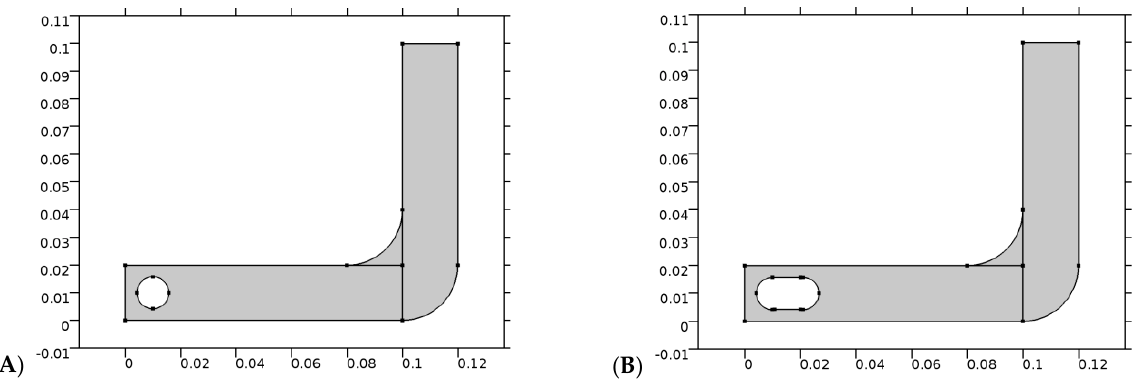
Figure 1. A simulation of a segmented GI tract and the motion of the endoscopic modules along that tract. ( A ) Spherical-shaped modules; ( B ) capsule-shaped modules.